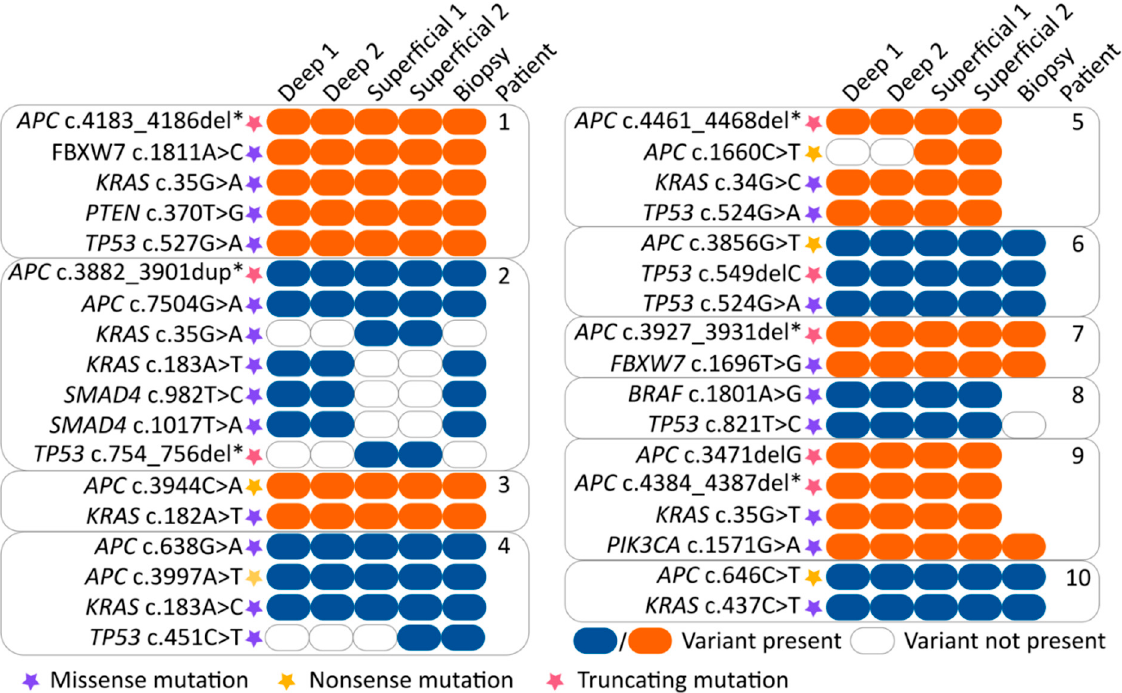
Figure 3. Overview of specific mutations found in all samples. The various mutations are represented by orange and blue colored boxes (blue/orange box = mutation variant is present and clear box = mutation variant is absent). Purple, yellow and red stars indicate the function of the found mutation (purple = missense mutation, yellow = nonsense mutation and red = truncating mutation). The location of the tumor sample is indicated at the top of the boxes. Abbreviation: del*, deletion of several nucleotides. dup*, duplication of several nucleotides